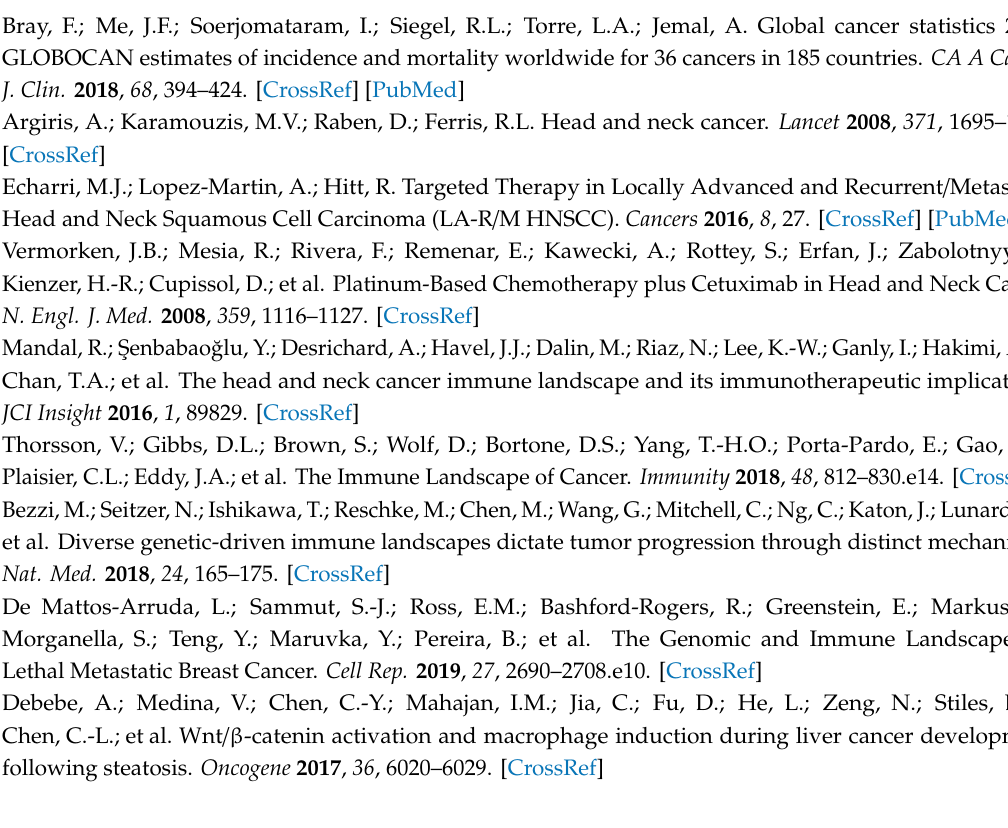
genes, Table S4: Genetic aberrations of 830 cancer genes in each mouse model, Table S5: Definitions of 11 major signaling pathways and 3 biological machineries, Table S6: Metastatic gene list of 1283 metastasis-related genes, Table S7: Genetic aberrations of 1116 metastatic genes and copy number change in 1156 metastatic genes in TCGA-HNC patients ( N = 510), Table S8: Genetic aberrations of 149 metastatic genes and copy number change in 894 metastatic genes in 5 mouse models, Table S9: Comparison of TCGA-HNC and IMPACT-MSK head and neck cancer subsites as well as KRAS / ERBB4 mutations. Table S10: List of immunomodulatory genes and annotations, Table S11: List of druggable candidate genes, Table S12: Potential druggable genetic events in each of the 5 mouse models, Table S13: Potential druggable genetic events in TCGA-HNC ( N = 510). Table S14: Summary of key similarities and di ff erences in genetic events including metastasis-related genes, immunomodulatory genes, and potential druggable events and corresponding therapeutic drugs for easy referencing and utility